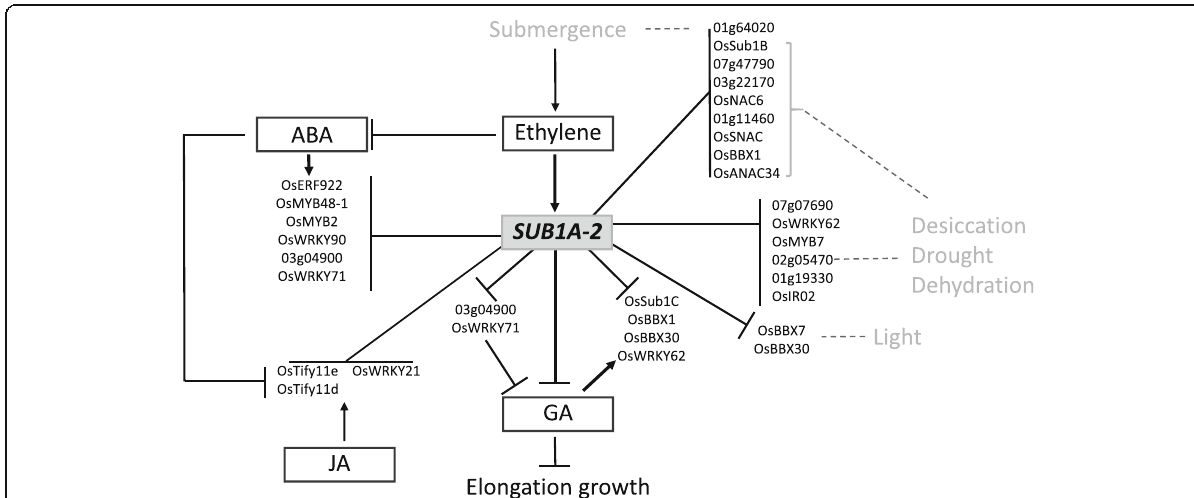
Fig. 4 Differentially expressed transcription factor genes in IR64. An overview of the transcription factor genes and their related pathways is provided for all genes that are specifically submergence-responsive in IR64 which carries the SUB1A-2 allele. The figure is based on a literature review, see text for